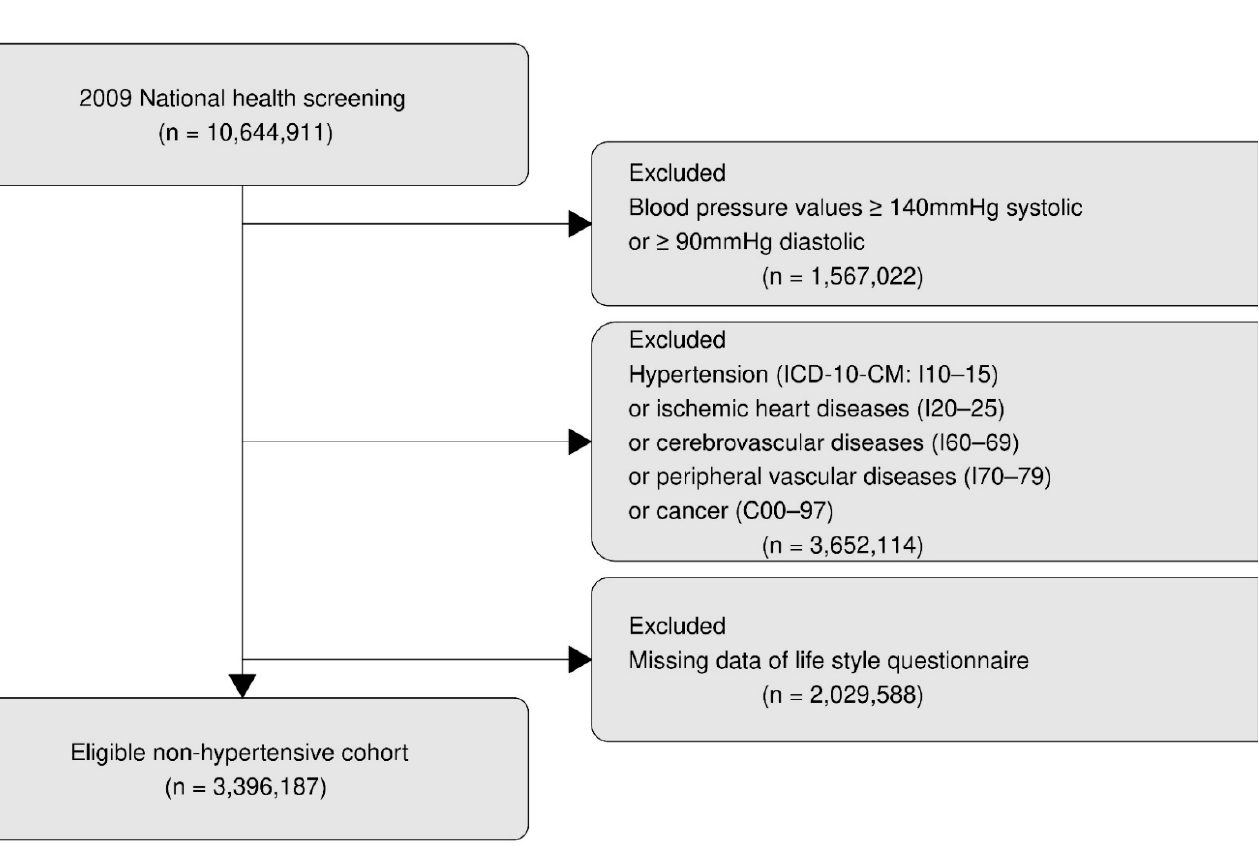
Figure 1. Flowchart of study participants.